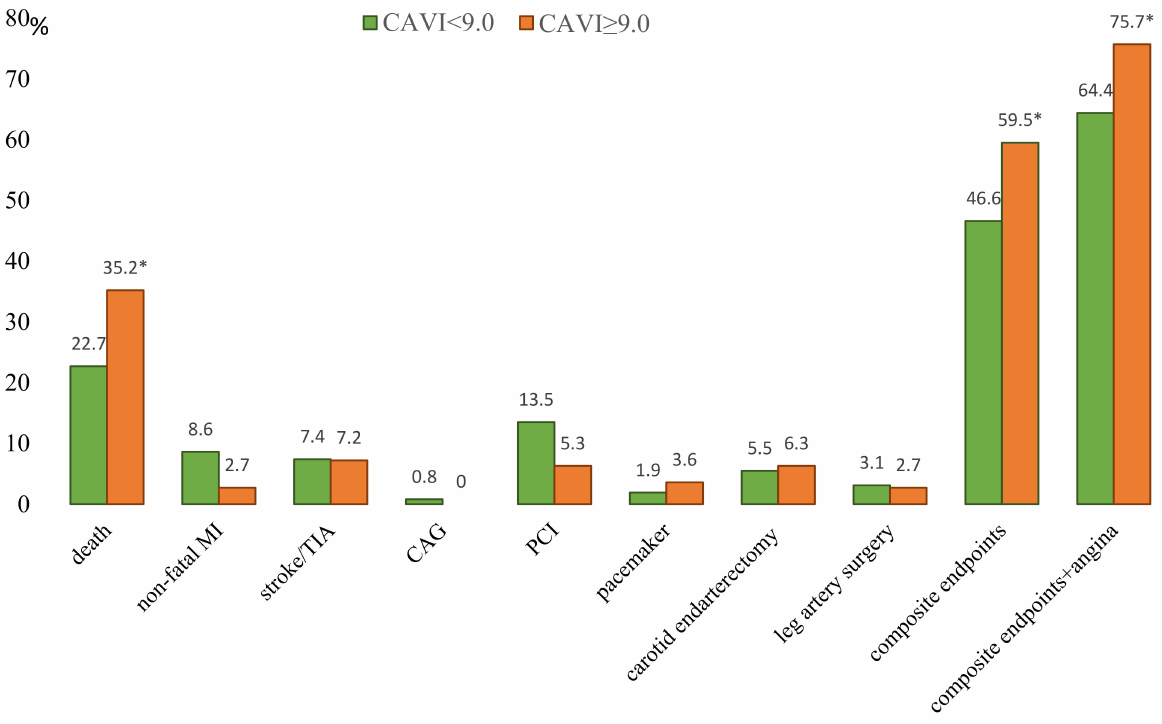
Figure 3. Structure of complications in the long-term period after CABG. Notes: MI—myocardial in- farction; TIA—transient ischemic attack; PCI—percutaneous coronary intervention; CAG—coronary angiography; CABG—coronary artery bypass grafting; CAVI—cardio-ankle vascular index. * p < 0.05 compared with normal CAVI group.